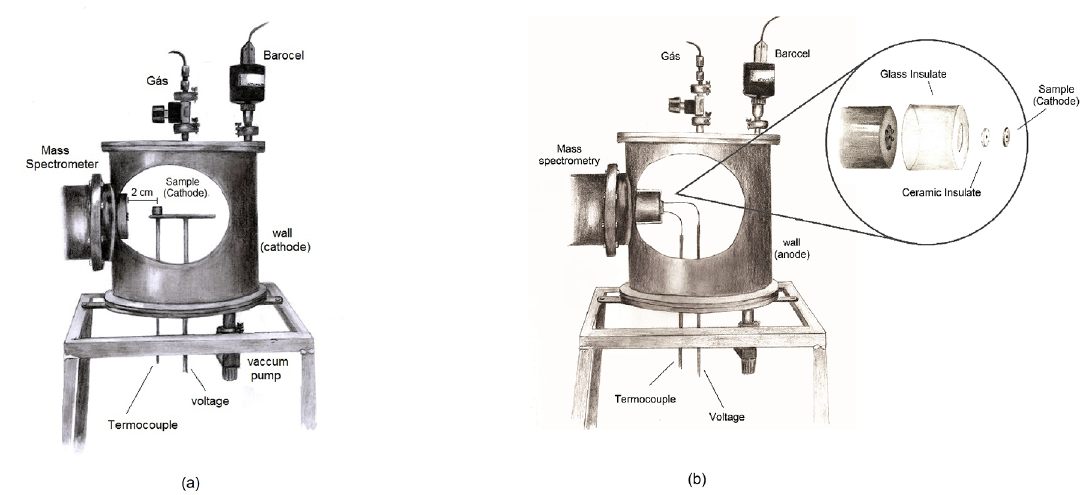
Figure 1. Schematic representation of the experimental set-up. (a) Bulk Configuration and (b) Surface